Question: In a single sentence, describe what this figure presents.
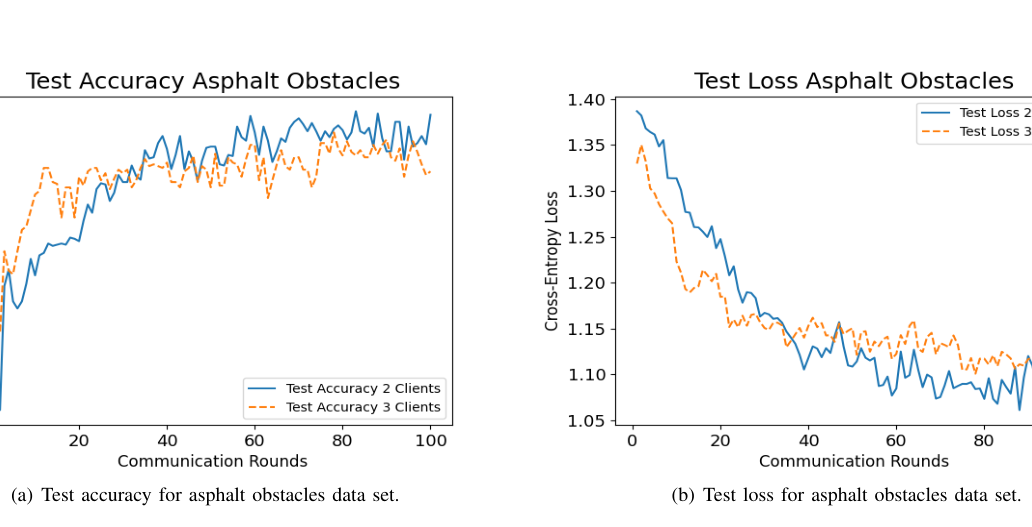
Answer: Performance of asphalt obstacles data set.